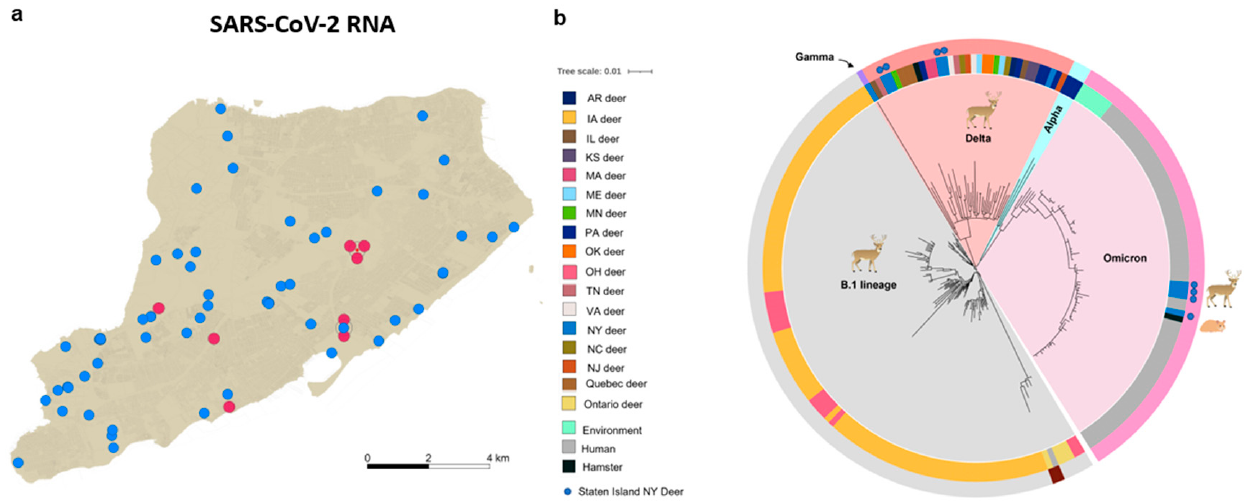
Figure 1. Distribution and whole-genome single nucleotide polymorphism (SNP)-based phylogenies of SARS-CoV-2 recovered from white-tailed deer on Staten Island, New York: ( a ) the spatial distribu- tion of the collection sites of nasal and tonsillar swabs from white-tailed deer that were tested for the presence of SARS-CoV-2 viral RNA; red circles show sites where swabs were positive for SARS-CoV-2 viral RNA, and blue-filled circles show swabs that were negative; ( b ) whole-genome sequences of eight newly characterized white-tailed-deer-origin SARS-CoV-2 genomes were analyzed in the con- text of 135 publicly available white-tailed-deer-origin SARS-CoV-2 isolates, and 63 arbitrarily selected SARS-CoV-2 Omicron genomes circulating amongst humans in New York City during this same time period, as well as representative isolates from the environment or from Syrian hamsters (SI, Table S2); the genome sequences were screened for quality, for SNP positions called against the SARS-CoV-2 reference genome (NC_045512), and for SNP alignments used to generate a maximum-likelihood phylogenetic tree, using